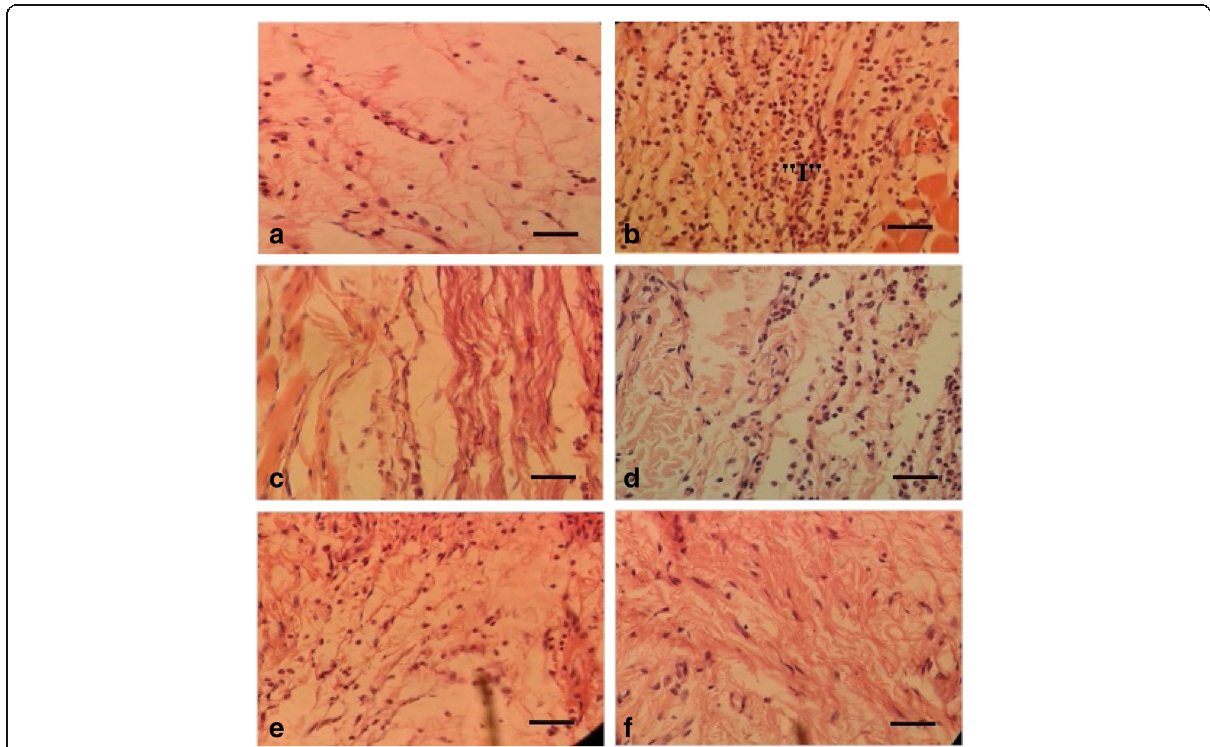
Fig. 2 Histological evaluation of anti-inflammatory effects of methanolic extract of P. niruri a Normal control , b Carrageenan control, c 20 mg/kg